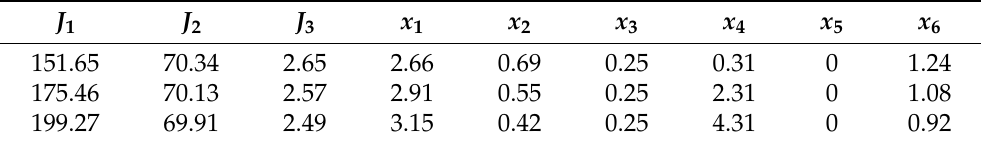
Table 2. Balanced solutions obtained from the Pareto front with